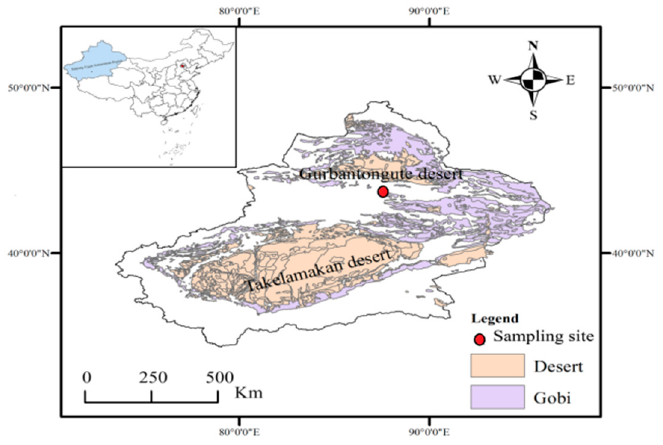
Figure 1. Location of sampling site.